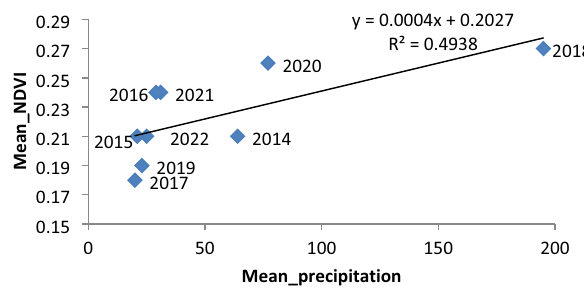
Fig. 6 Relationships between NDVI and